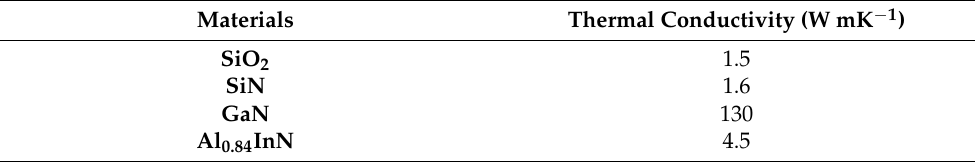
Table 1. Example of thermal conductivity for materials used for GaN-based